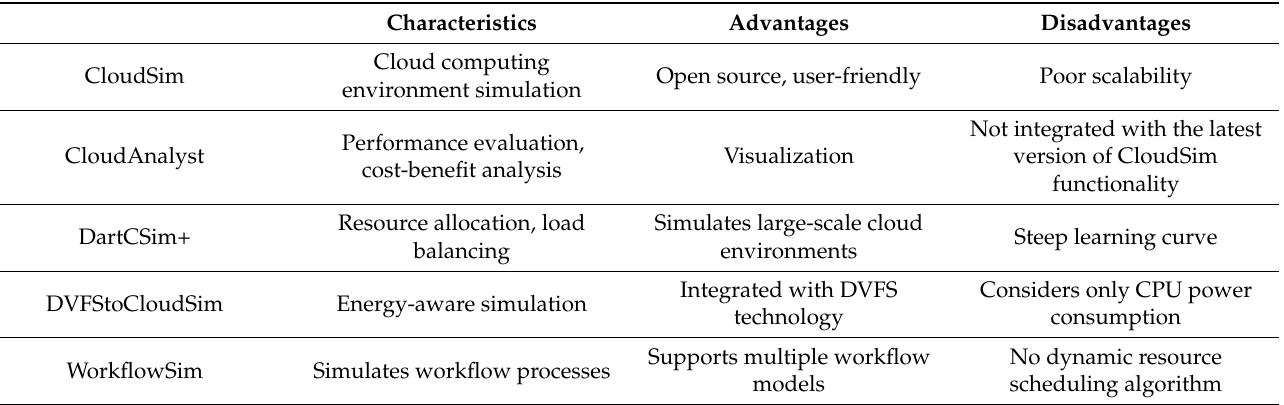
Table 1. Comparison of different simulation tools.